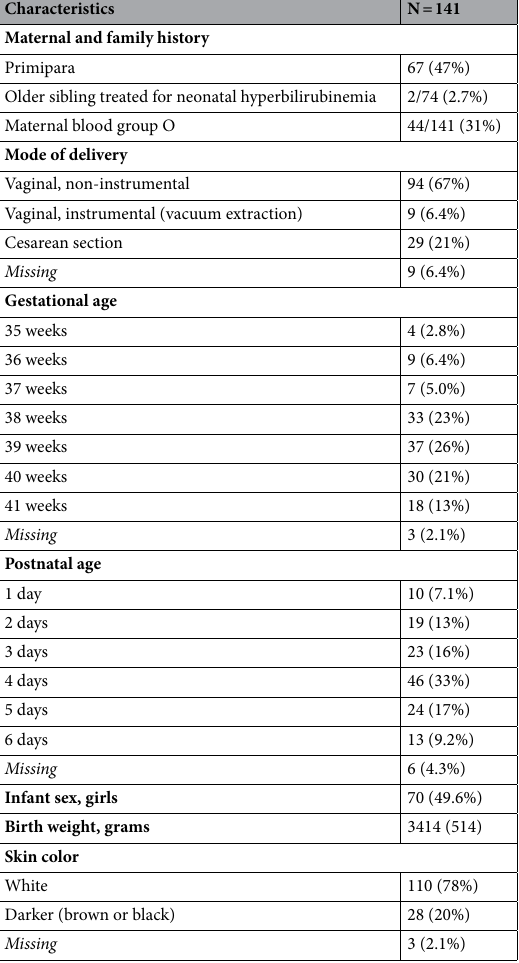
Table 1. Characteristics of the participants. Data are numbers (%) or mean (SD).